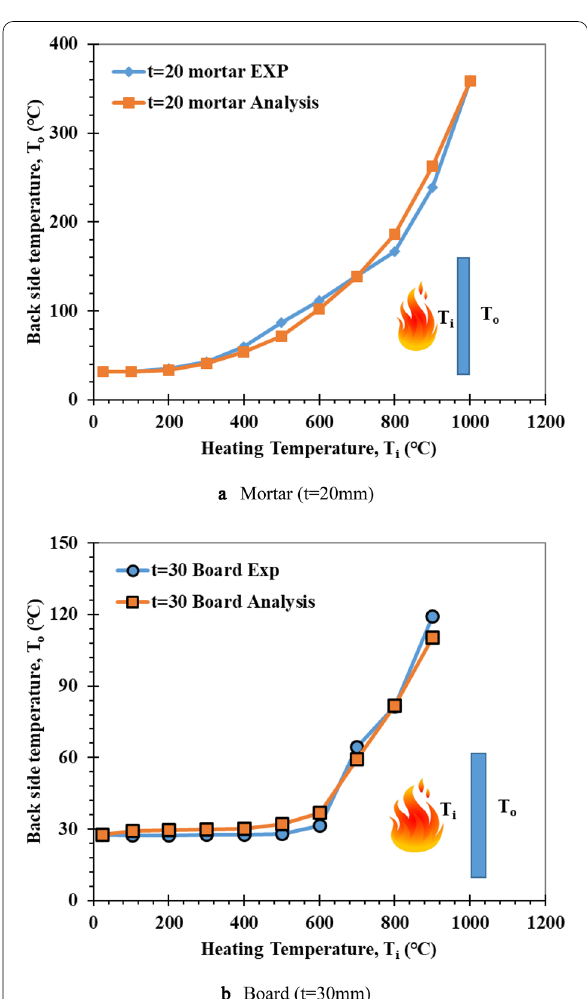
Fig. 26 Test and analytical results for temperature transfer of FP mortar and